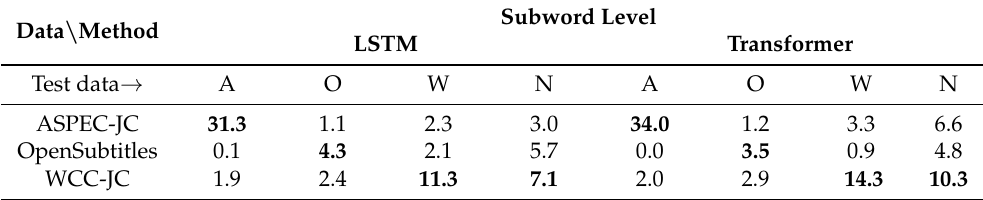
Table 5. Japanese → Chinese translation experiment results in subword level (BLEU